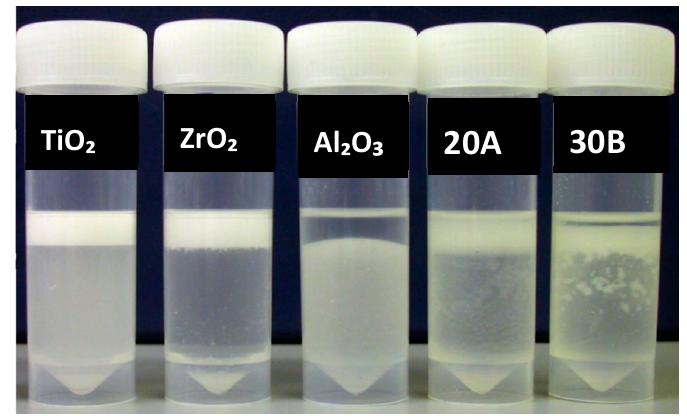
Figure 8. Particles subsequent to silane treatment, method I, mixed with monomer stored for one hour from left to right; silane treated TiO 2 , ZrO 2 , Al 2 O 3 and closite 30B and 20A.